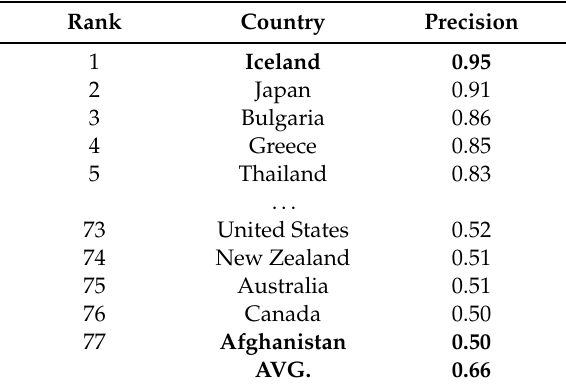
Table 2. Prediction precision of each country.